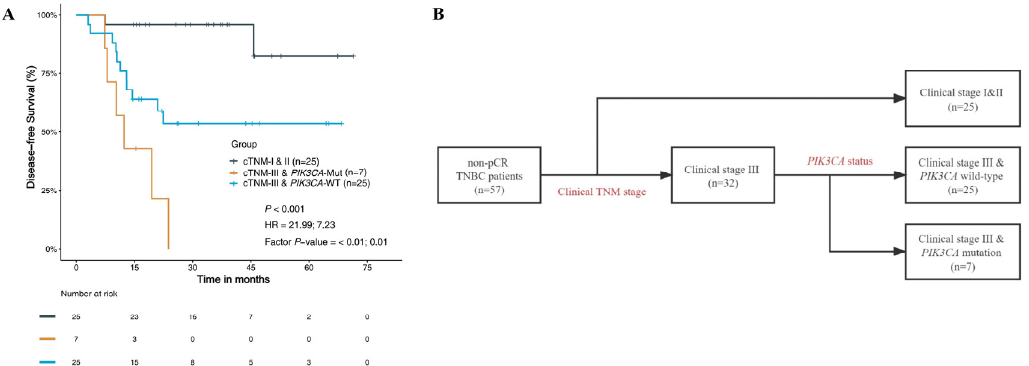
Figure 4. Prognostic risk assessment based on clinical and molecular features of patients with non- pCR TNBC. ( A ) DFS based on clinical TNM stage and PIK3CA status; ( B ) flowchart of prognostic risk assessment. DFS, disease-free survival; pCR, pathologic complete response; TNBC, triple-negative breast cancer; cTNM, clinical TNM stage; Mut, mutation; WT, wild-type; HR, hazard ratio.